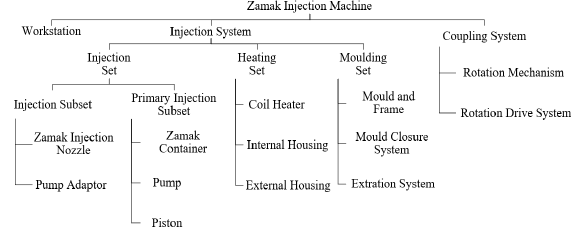
Figure 1. Pareto’s analysis on spare part consumption by accumulated acquisition cost (Overall expenses). Figure 2. ZHPIM equipment structure by main systems, sets and working groups.